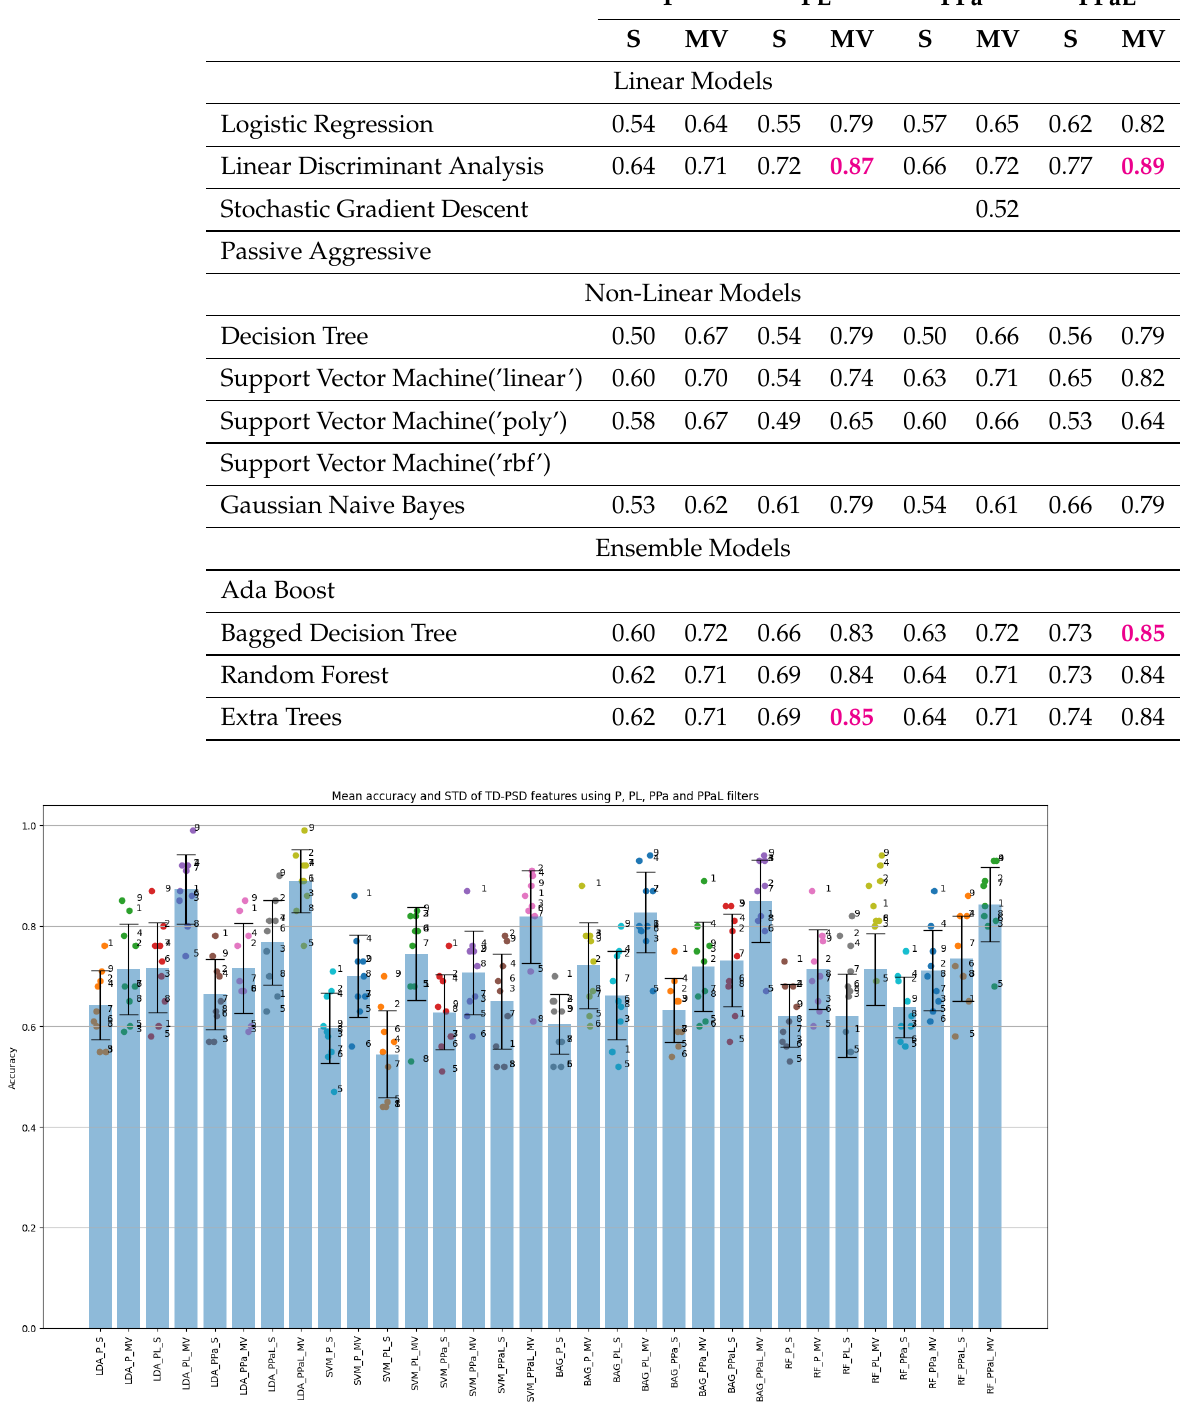
Figure 3. Accuracy value distributions across users for the most promising combinations of Table